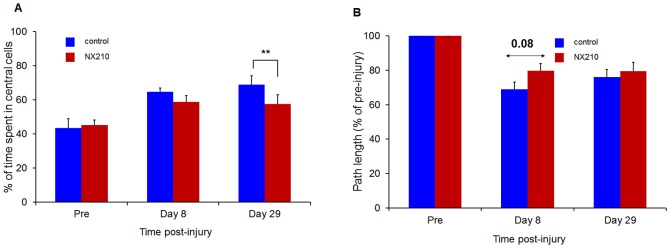
Effects of NX210 on functional recovery after SCI: open arena test.(A) Percentage of time spent in central cells. (B) Path length. NX210-treated rats (n = 8, red) showed significant improvement in the percentage of time spent in central cells and path length at post-injury time points compared to vehicle-treated rats (n = 8, blue) and the difference between treated and vehicle groups increased throughout the study for the percentage of time spent in central cells. Data are presented as group mean ± SEM, * p<0.05.